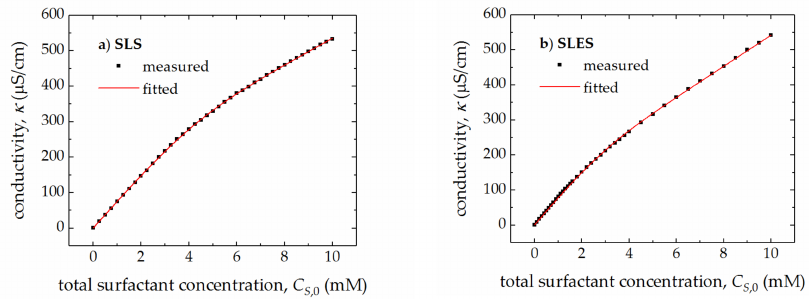
Figure 2. The measured and fitted values of electrical conductivity, κ , of the aqueous solutions of SLS ( a ) and SLES ( b ) vs. the total surfactant concentration, C S ,0